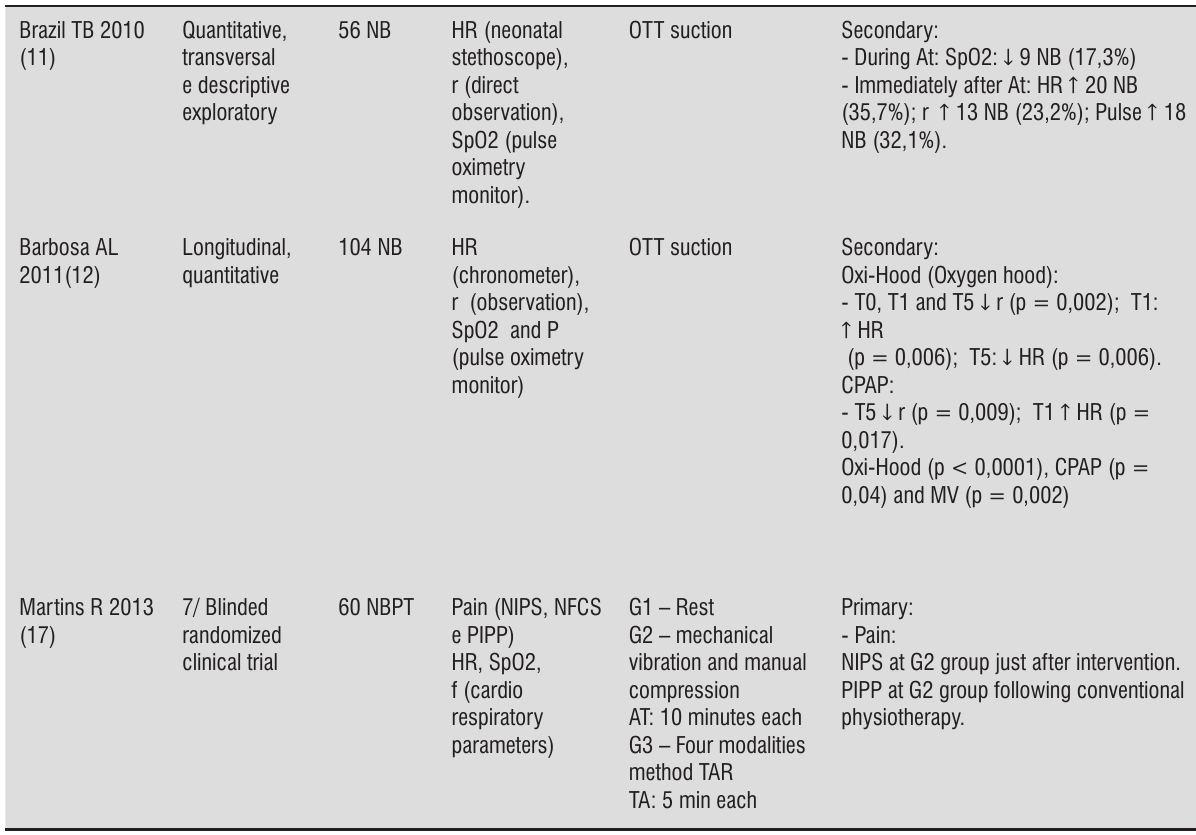
Table 1 - Main data from selected studies